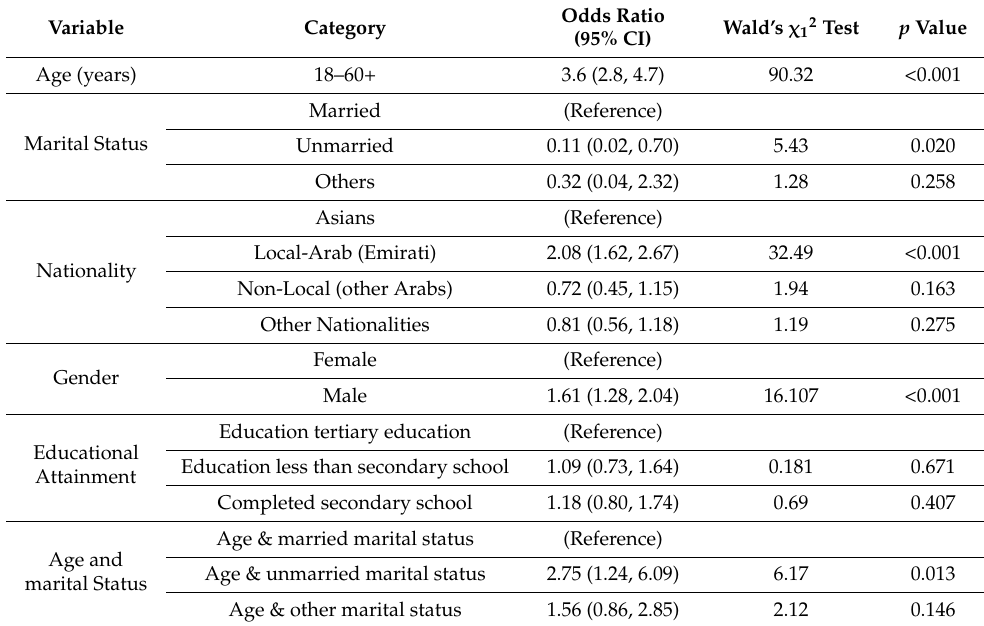
Table 2. Multivariate logistic regression model for NCD among the Dubai Population